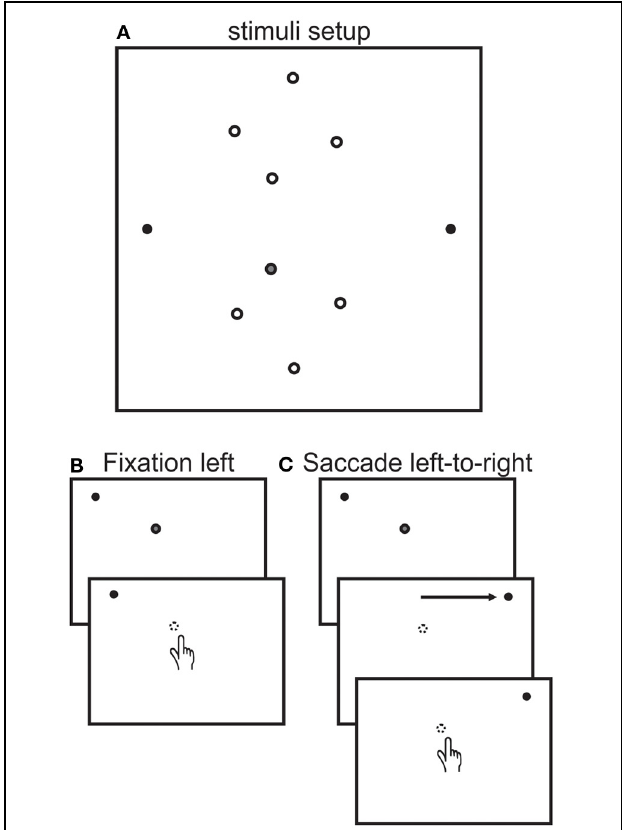
FIGURE 2 | Stimuli setup and trial sequence. (A) Stimuli setup. Participants reached to one of 8 targets (open circles) while fixating on either the left (30 ◦ ) or right (30 ◦ ) fixation dots (black dots) or after making a saccade from the left to the right fixation dots. Targets were located at 15.5 ◦ , 9.5 ◦ , 5.5 ◦ left and 3.5 ◦ right of center and 7 ◦ , 13 ◦ , 15 ◦ , and 24 ◦ up or down of center. Target locations were illuminated with a laser pointer by the experimenter from behind the screen facing the participant. The gray filled target is the one used to describe task sequence next. (B) Fixation left sequence. Each trial began with the participant fixating on the left fixation dot. Next the experiment illuminated the target (gray filled dot). The participant then reached to the location of the target, which was automatically extinguished when the participant released the start trigger. The participant remained fixated on the fixation dot throughout the trial. The fixation right session was identical except that participants fixated on the right fixation dot. (C) Saccade left-to-right sequence. Each trial began in the same way as the fixation left sequence. Next the participant made a saccade from the left to the right fixation dot. For the patient and for targets in the lower visual field, the target was no longer visible once the patient made the saccade because of the patient’s blind field. For the control subjects, the target was extinguished before the saccade was executed. After that, both groups reached for remembered location of the target.